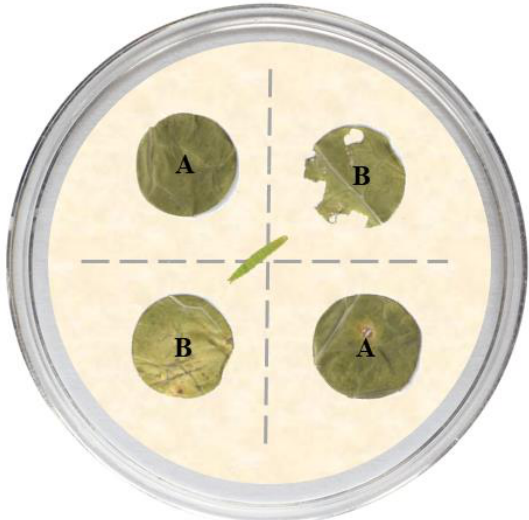
Figure 3. Comparison of consumed leaf area for P. xylostella between collard green discs treated with the botanical extract of M. albicans (10%) (A) and control treatment (B).